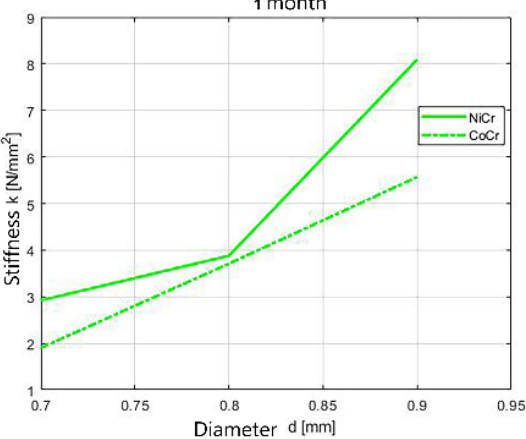
Figure 13. Stiffness dynamics of orthodontic wires.